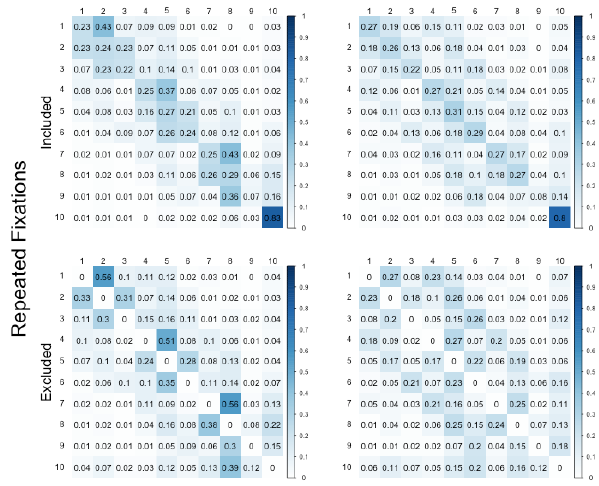
Figure 8. Average transition matrices of the two clusters. Left panel shows matrices of the first cluster with (top) and without (bottom) repeated fixations, right panel shows matrices of the sec- ond cluster with (top) and without (bottom) repeated fixations.